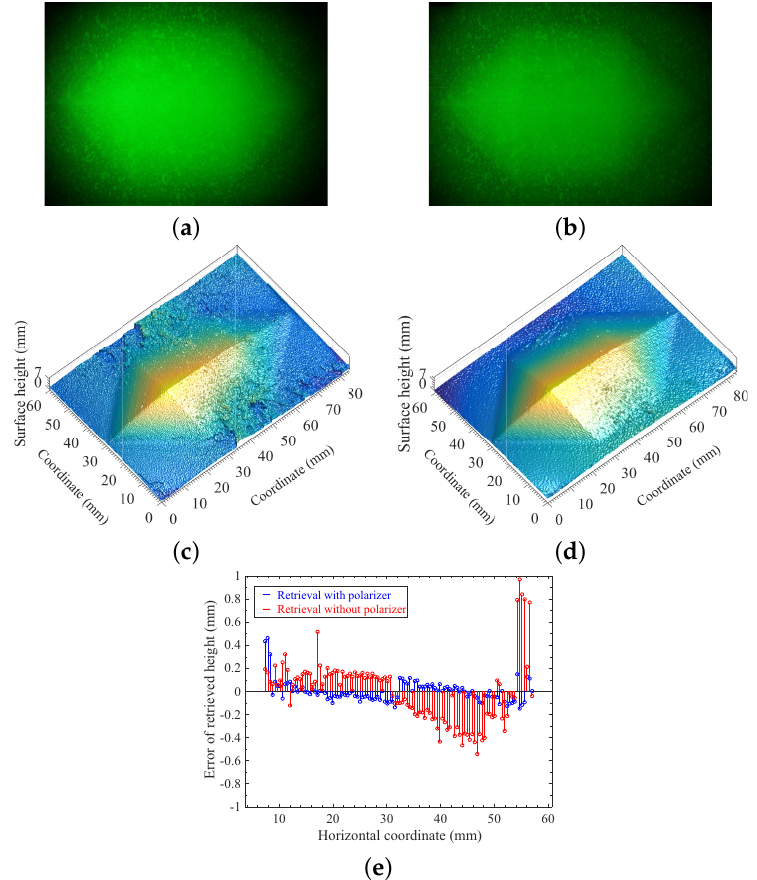
Figure 5. Measurement and reconstruction of the heptahedron-shape vulcanized silicone rubber illuminated by monochromatic sinusoidal fringe pattern at 532 nm without background illumination. ( a ) Image without an optical polarizer. ( b ) Image with an optical polarizer. ( c ) Reconstruction using the measurement of ( a ). ( d ) Reconstruction using the measurement of ( b ). ( e ) Comparing the absolute-error distribution of retrieved surface height on the cross section perpendicular to the ridge with actual values based on the data in ( c , d